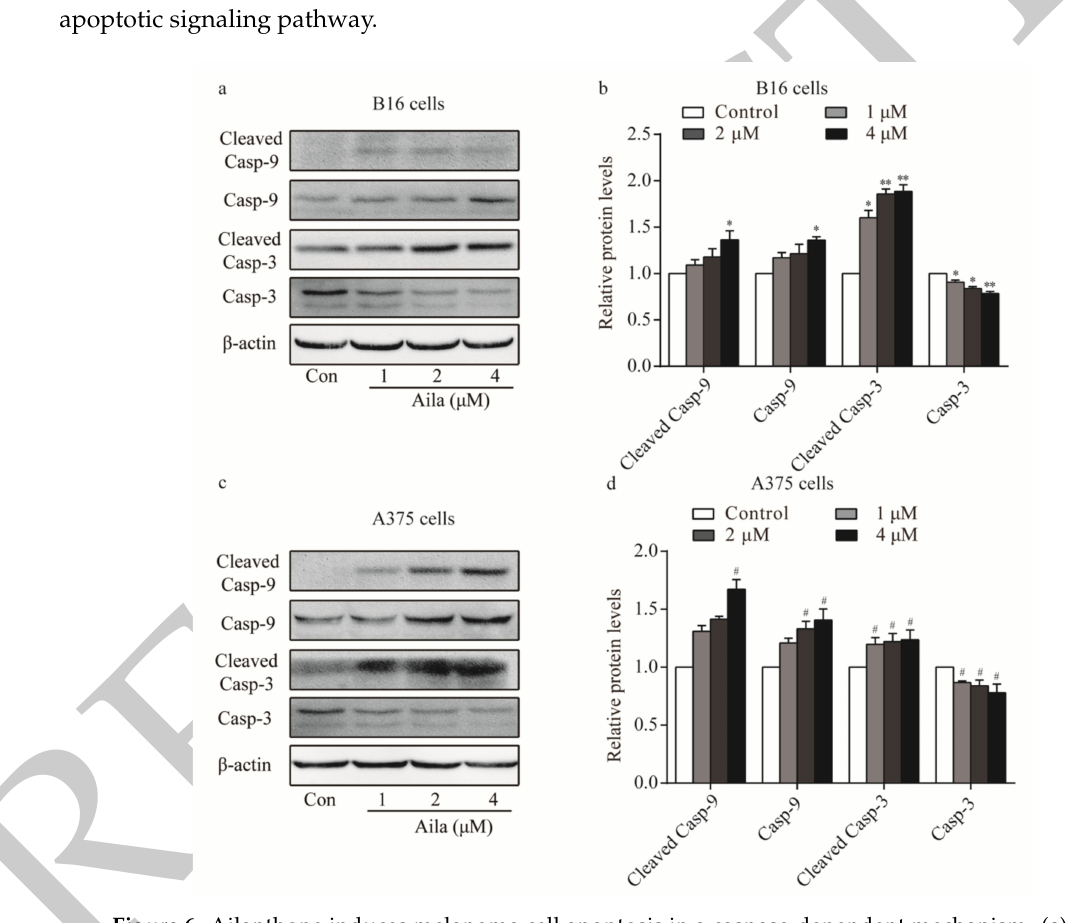
Figure 6. Ailanthone induces melanoma cell apoptosis in a caspase-dependent mechanism. ( a ) The expression levels of caspase-9, cleaved caspase-9, caspase-3, and cleaved caspase-3 in ailanthone-treated B16 cells were examined by Western blotting. ( b ) Quantitative analysis of the expression levels of caspase-9, cleaved caspase-9, caspase-3, and cleaved caspase-3 in ailanthone-treated B16 cells. * p < 0.05, ** p < 0.01 compared with the control B16 cells. ( c ) The expression levels of caspase-9, cleaved caspase-9, caspase-3, and cleaved caspase-3 in ailanthone-treated A375 cells were examined by Western blotting. ( d ) Quantitative analysis of the expression levels of caspase-9, cleaved caspase-9, caspase-3, and cleaved caspase-3 in ailanthone-treated A375 cells. # p < 0.05 compared with the control A375 cells. The data are presented as the mean ± SD ( n =